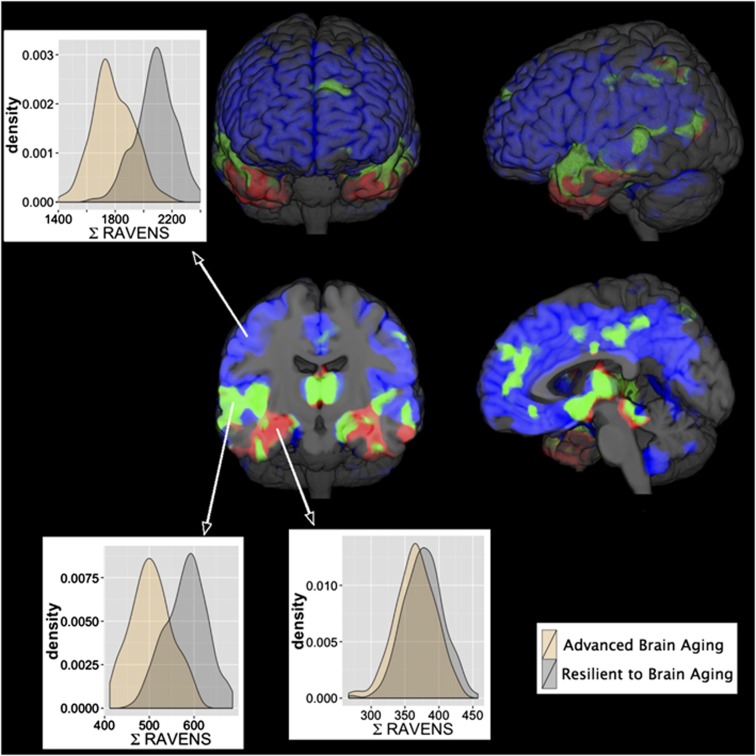
Patterns overlap. Blue: regions displaying significant regional atrophy patterns between resilient and ABA individuals; Red: regions displaying significantly AD-related patterns of atrophy in high vs low SPARE-AD individuals; Green: overlap of the blue and red regions (P<0.001 and FDR correction with q<0.001). Histograms are presented for gray matter volumes of blue/red/green regions for ABA and RA individuals. These results highlight the difference between advanced and clinical AD-like brain aging, and they also indicate that increased SPARE-AD values in advanced aging are entirely due to partial overlap (green) of underlying regions. ABA, advanced brain aging; FDR, false discovery rate; RA, resilient to aging; SPARE-AD, Spatial Patterns of Abnormality for Recognition of Early Alzheimer's Disease.